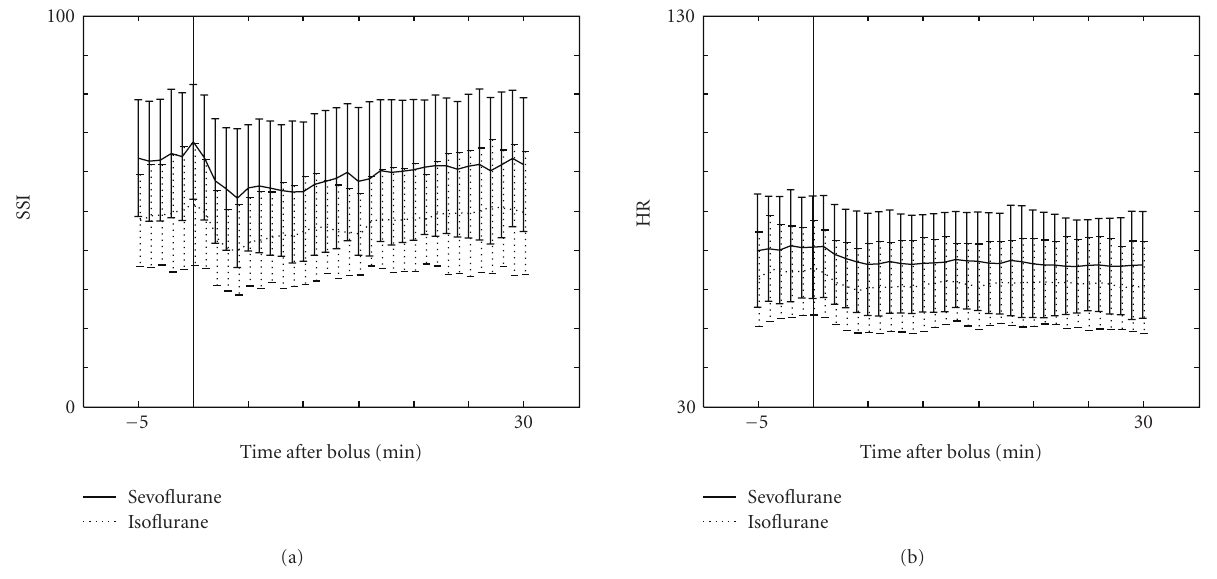
Figure 2: Mean surgical stress index (SSI ± SD) and heart rate (HR ± SD) values before and after fentanyl bolus (1.5 µ g kg − 1 ) during surgery in sevoflurane ( n = 20) and isoflurane ( n = 20)